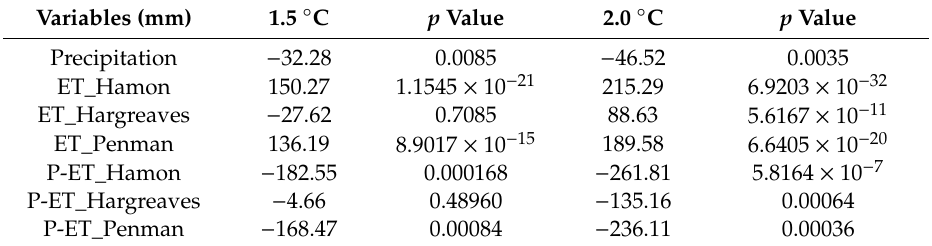
Table 3. Annual mean changes of precipitation, evapotranspiration, and water balance and the corresponding p values at 5% significance level. Bold p values indicate no significant